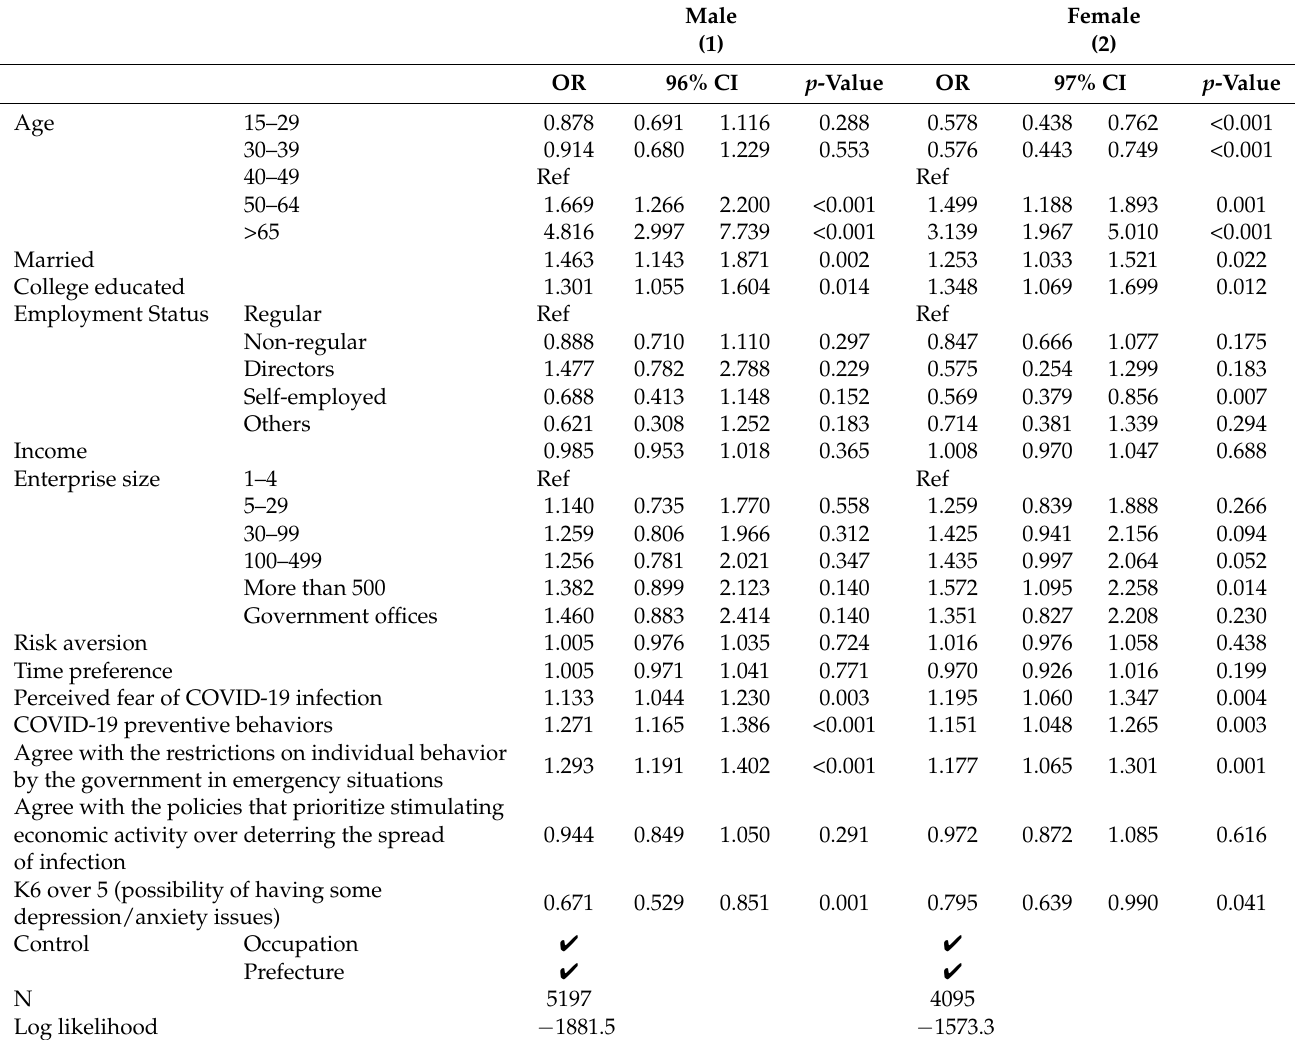
Table 4. Estimation results by